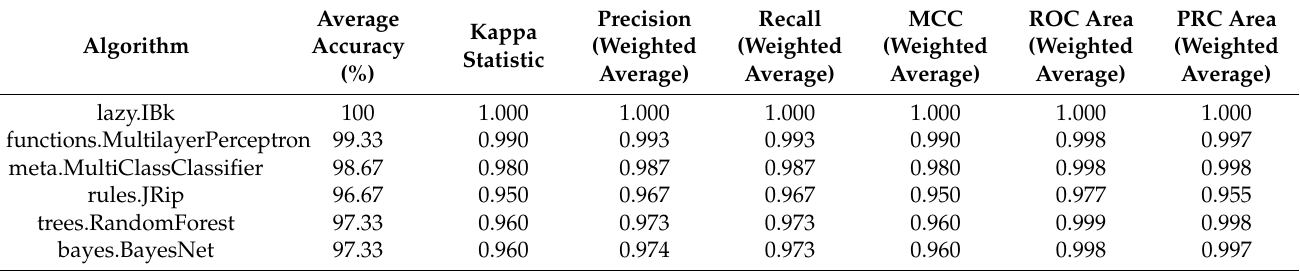
Table 3. The average accuracies, kappa statistic values, and weighted averages of other classification performance metrics for distinguishing unstored black currants and samples stored at room temperature for one week and two weeks using models combining selected textures from color space